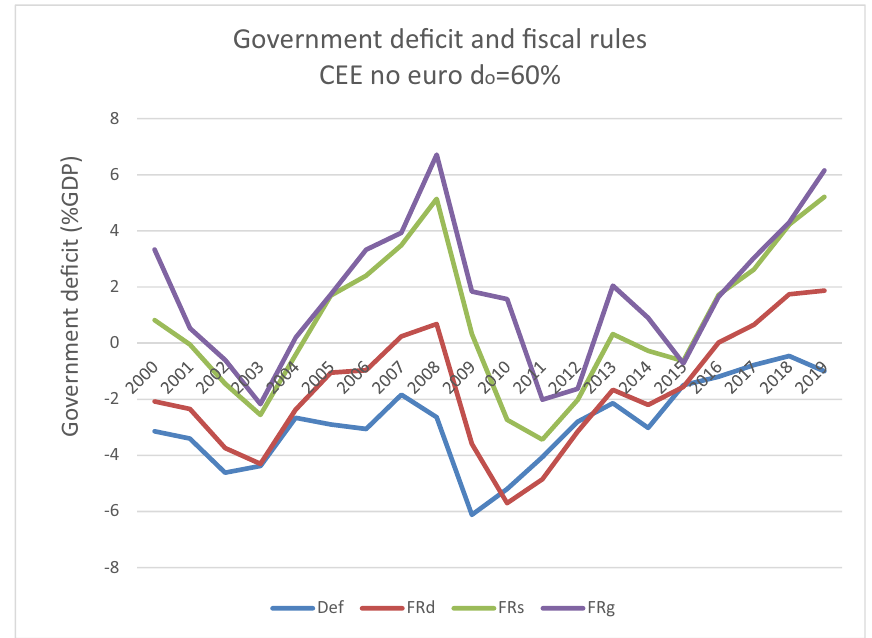
Figure 2.7: CEE no € countries government de fi cit ( Source: Own elaboration from data on Table 2 ) .